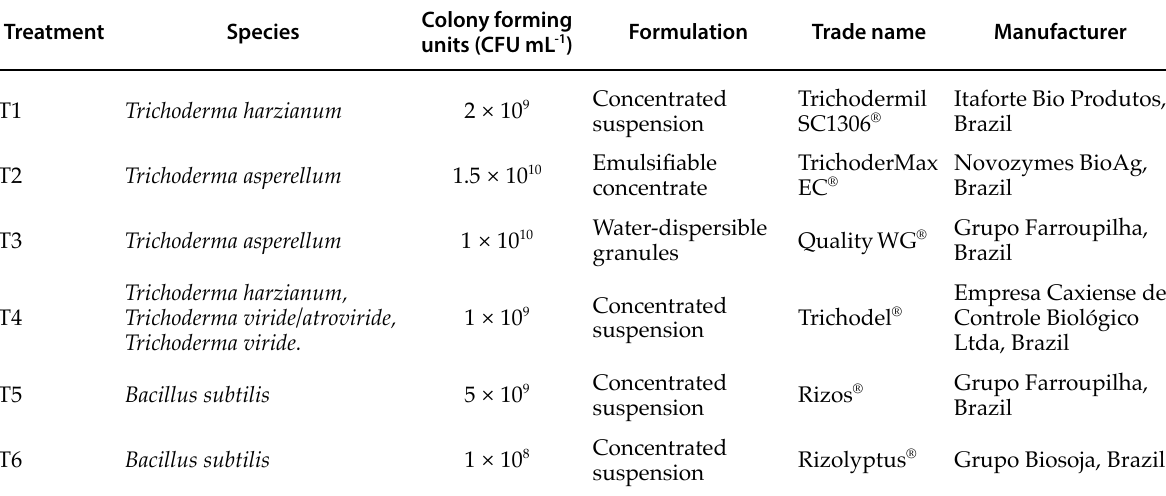
Table 2. Characteristics of six biocontrol products studied.